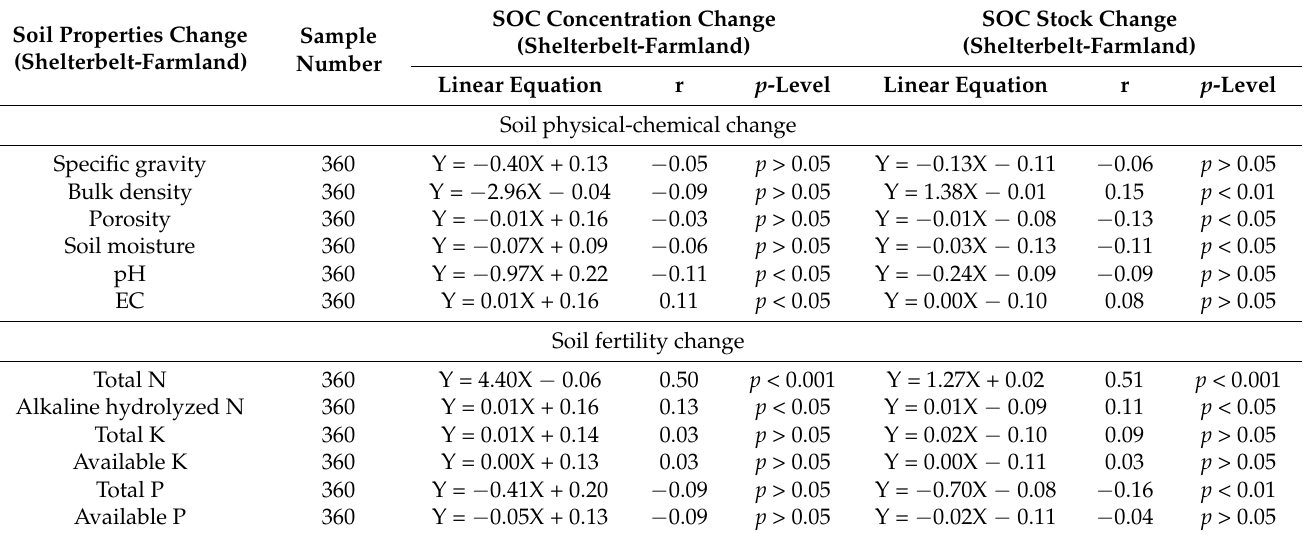
Table 6. Correlations between shelterbelt-induced changes in various soil properties and SOC sequestration in concentration and